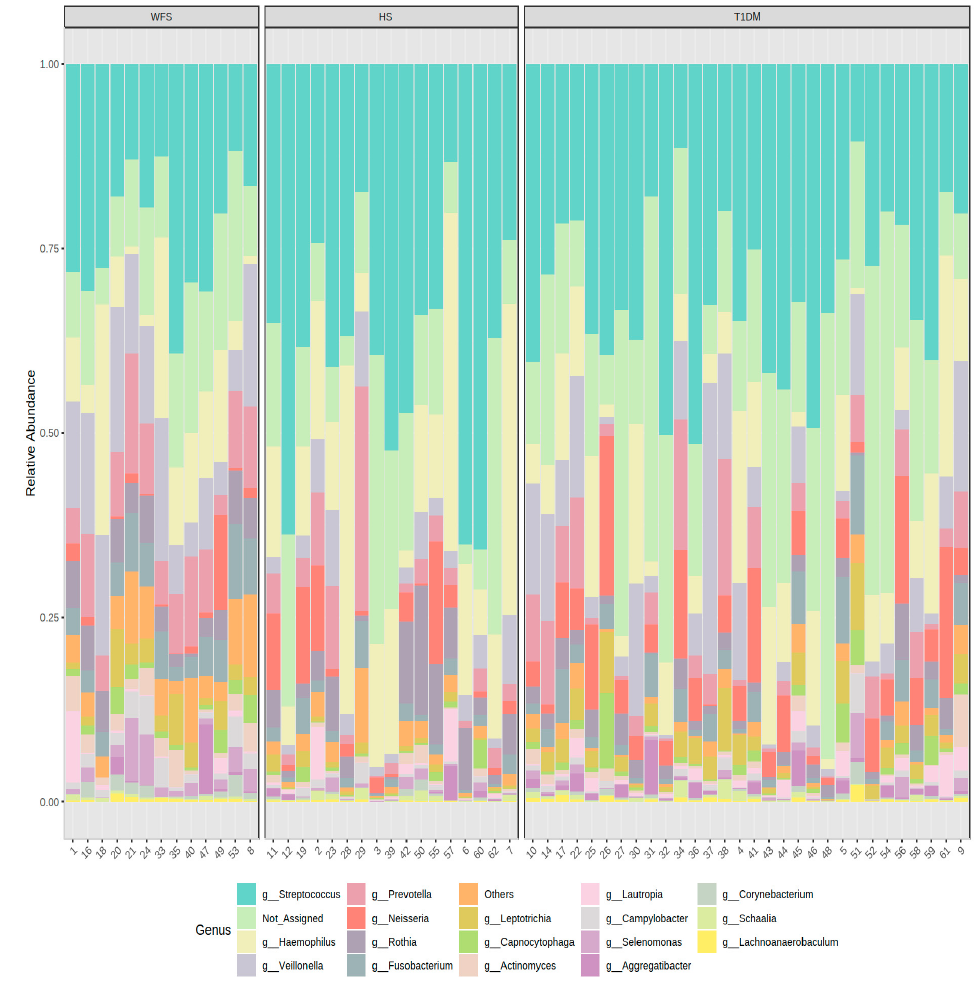
Figure 1. Taxonomic composition of community at bacteria genus level. WFS—Wolfram syndrome; HS—healthy subjects; T1DM—Type 1 diabetes mellitus.